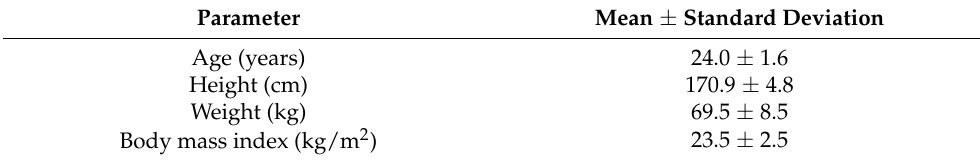
Table 1. Participant demographics (N = 18).